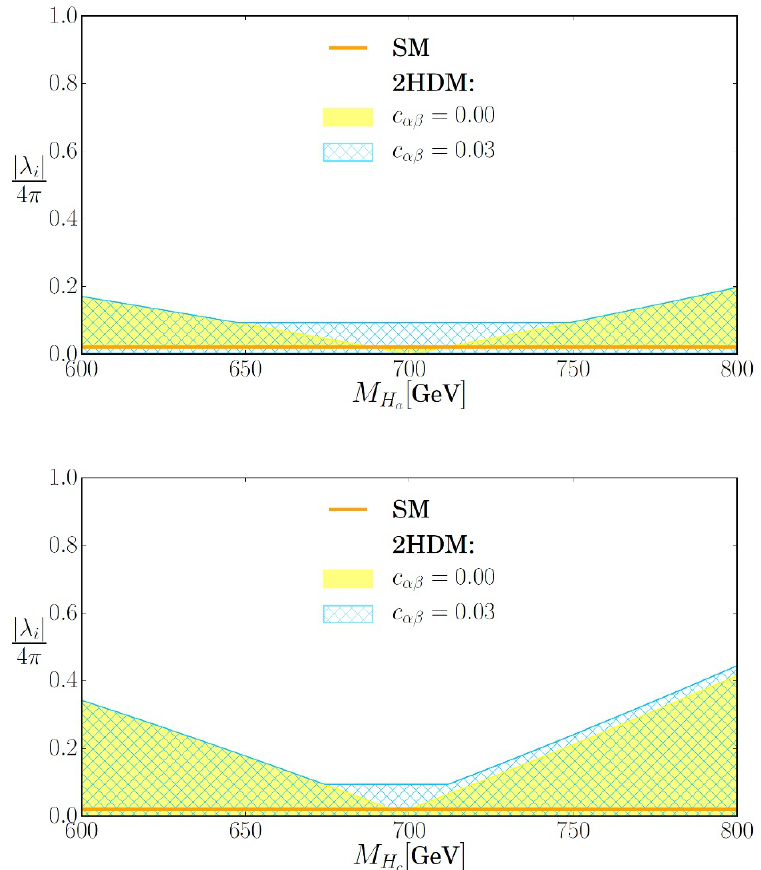
Figure 8 . The range between the minimal and maximal value of the modulus of the parameters (cid:21) i = (4 (cid:25) ) as a function of one of the new Higgs-boson masses is shown. All other new Higgs-boson mass scales are kept (cid:12)xed at 700 GeV. The range is also compared to the SM value (cid:21) SM = (4 (cid:25) ) = 0 : 02 (solid, orange line). The values shown here are for the non-MS schemes and thus no running is taken into